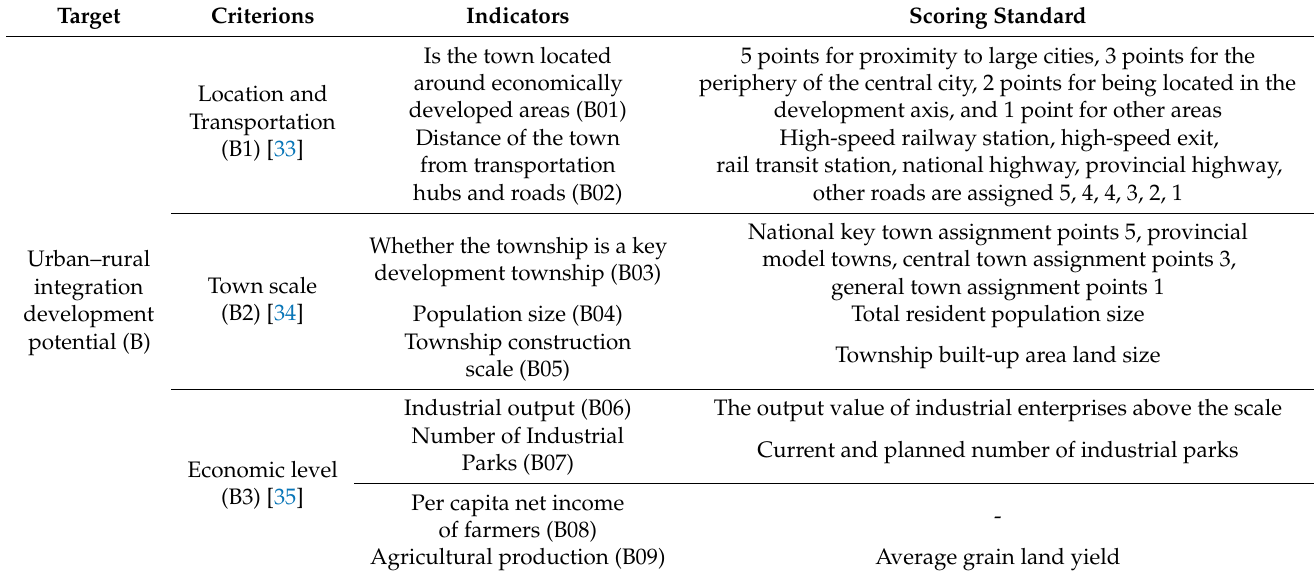
Table 2. Evaluation system of the potential level of urban–rural integration